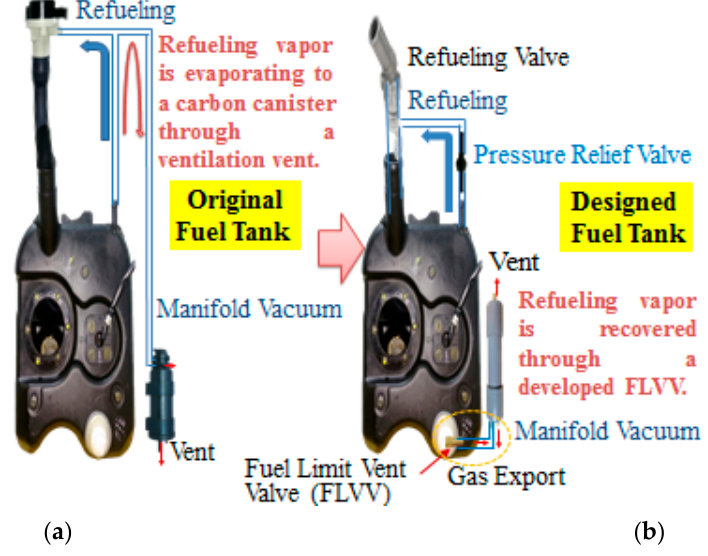
Figure 4. Schematic configuration for ( a ) the original fuel tank and ( b ) the designed fuel tank.